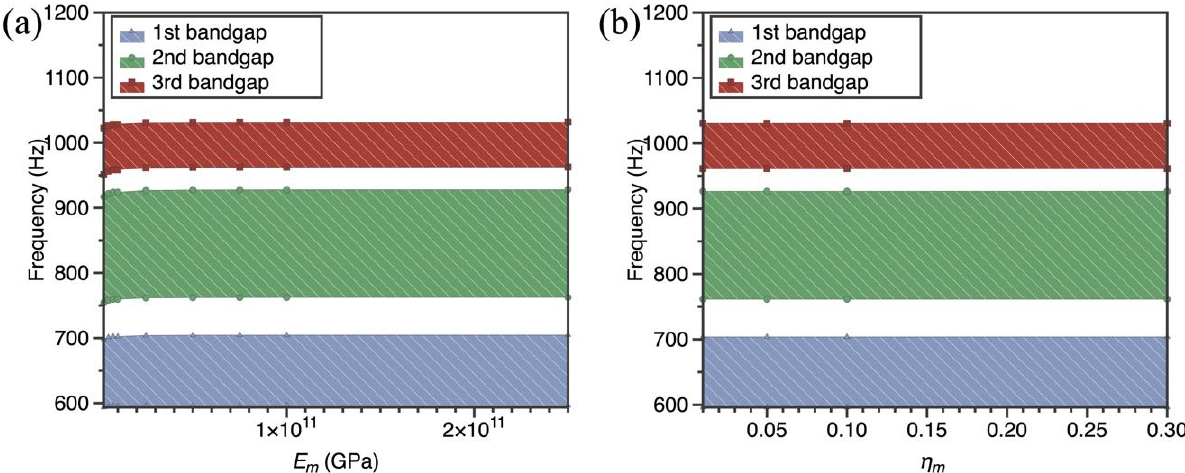
Figure 10. Effect of material parameters of resonant ring on bandgaps of the SPLCRR. ( a ) elastic modulus of resonant ring E m ( b ) damping ratio of the resonant ring η m